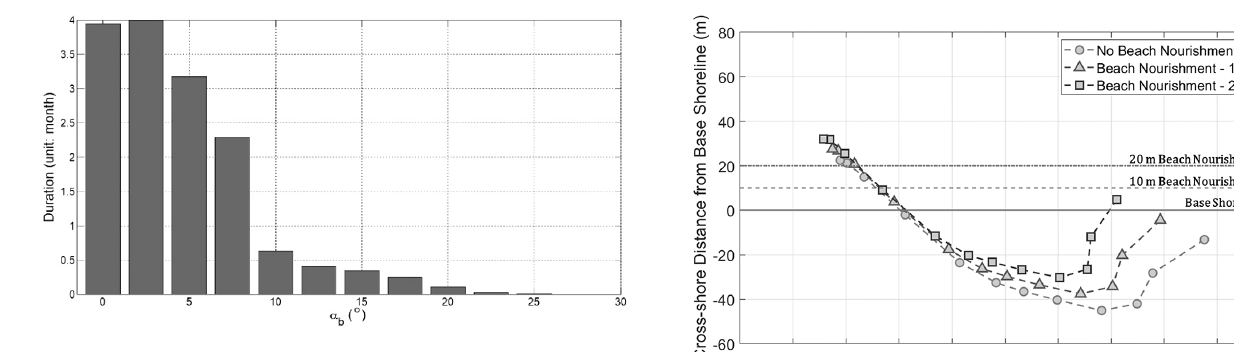
Figure 18. Duration of each oblique wave angle estimated from NOAA data (unit: month).